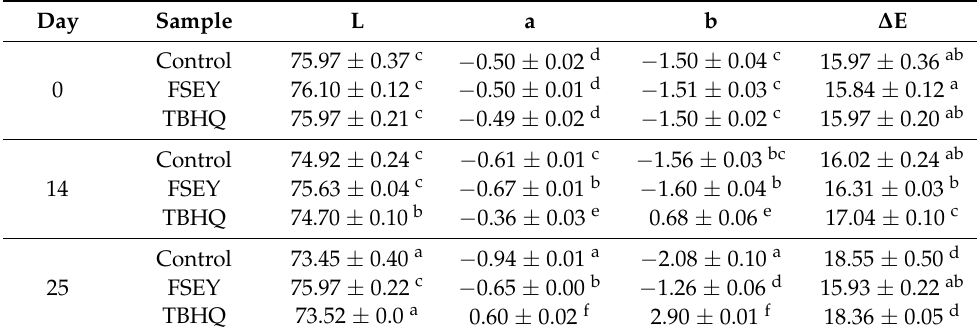
Table 2. Color changes of emulsions after storage at 37 ◦